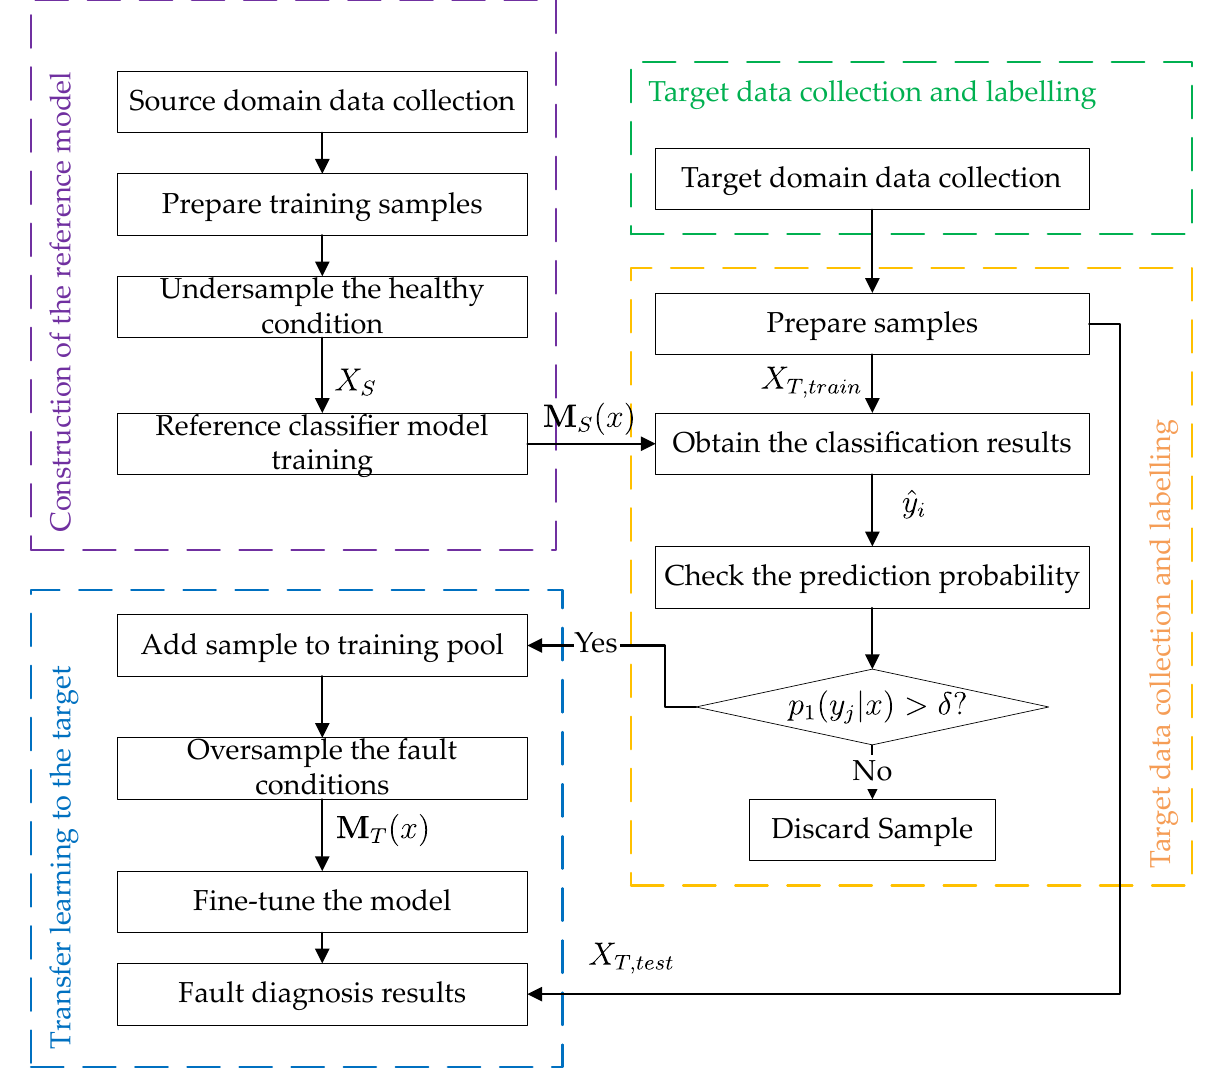
Figure 2. Flowchart of the semi-supervised transfer learning methodology. Table 1. Features used for the development of the fault detection and diagnosis